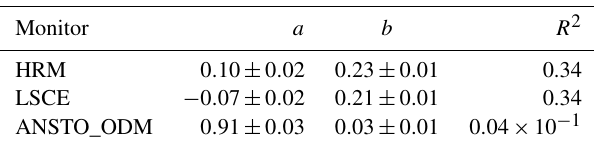
Table 4. Intercepts and slopes of the linear regression fits of the Eq.